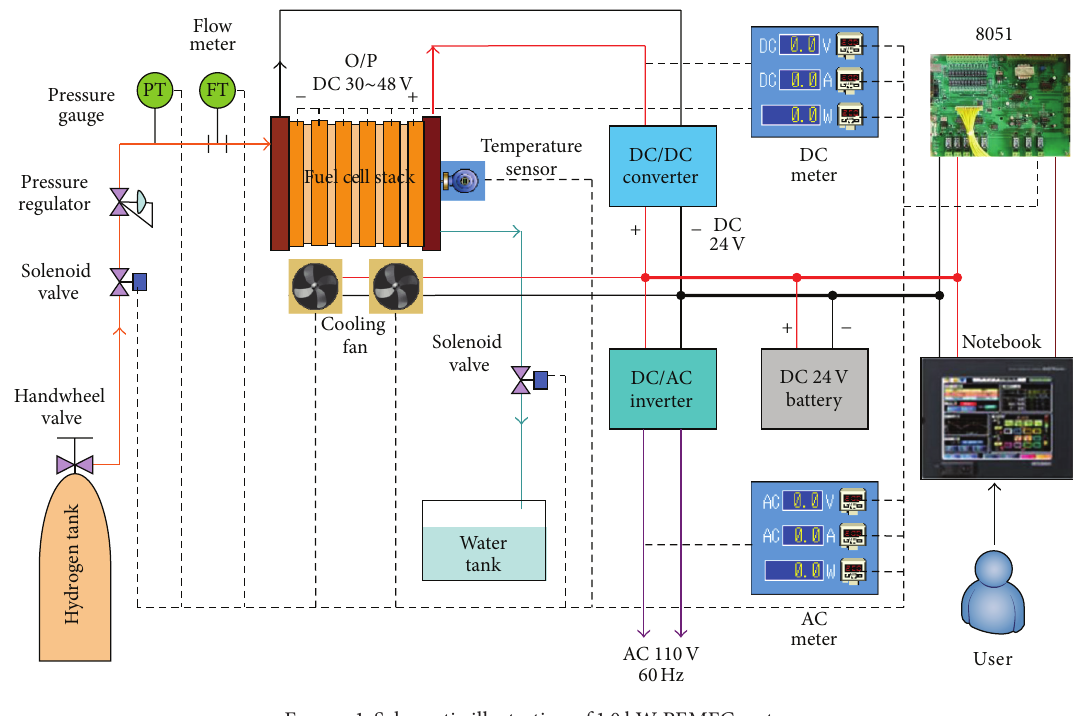
Figure 1: Schematic illustration of 1.0 kW PEMFC system.